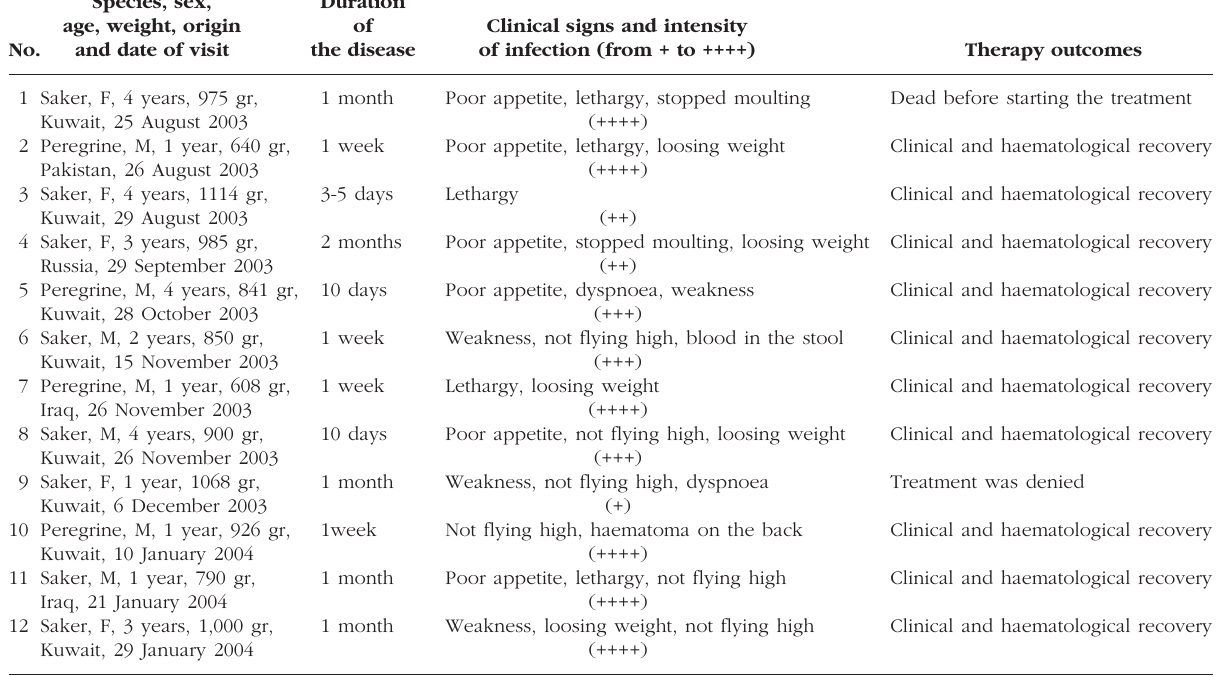
Table I. – Trypanosoma avium and response to therapy in 12 falcons from